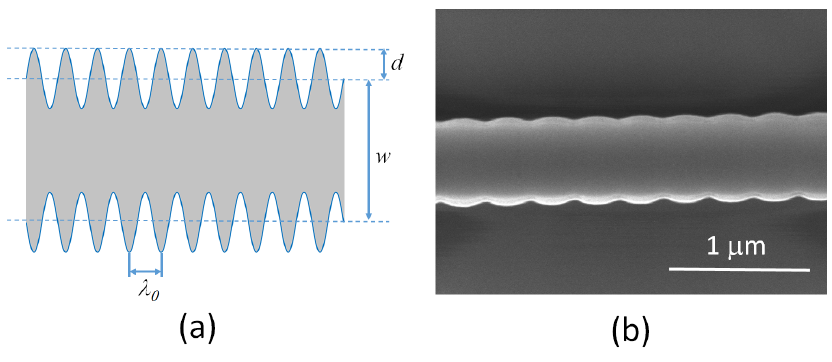
Figure 3. ( a ) Schematic of a sinusoidal sidewall perturbation Bragg grating, and ( b ) SEM image of a fabricated